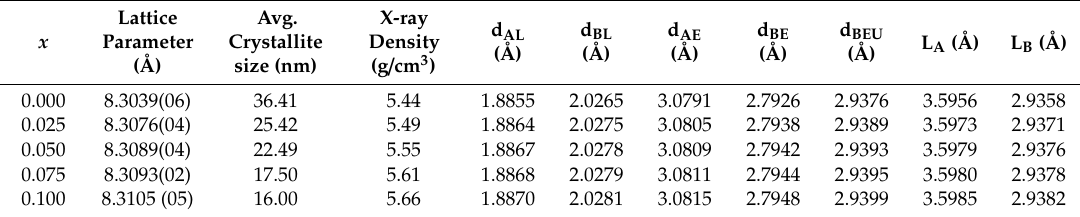
Table 2. Lattice parameters and Bond length of A-sites d AL and B-sites d BL , the tetrahedral edge d AE , the shared and unshared octahedral edges, d BE and d BEU and the hopping length at A-site L A and B- site L B for NiTb x Fe 2-x O 4